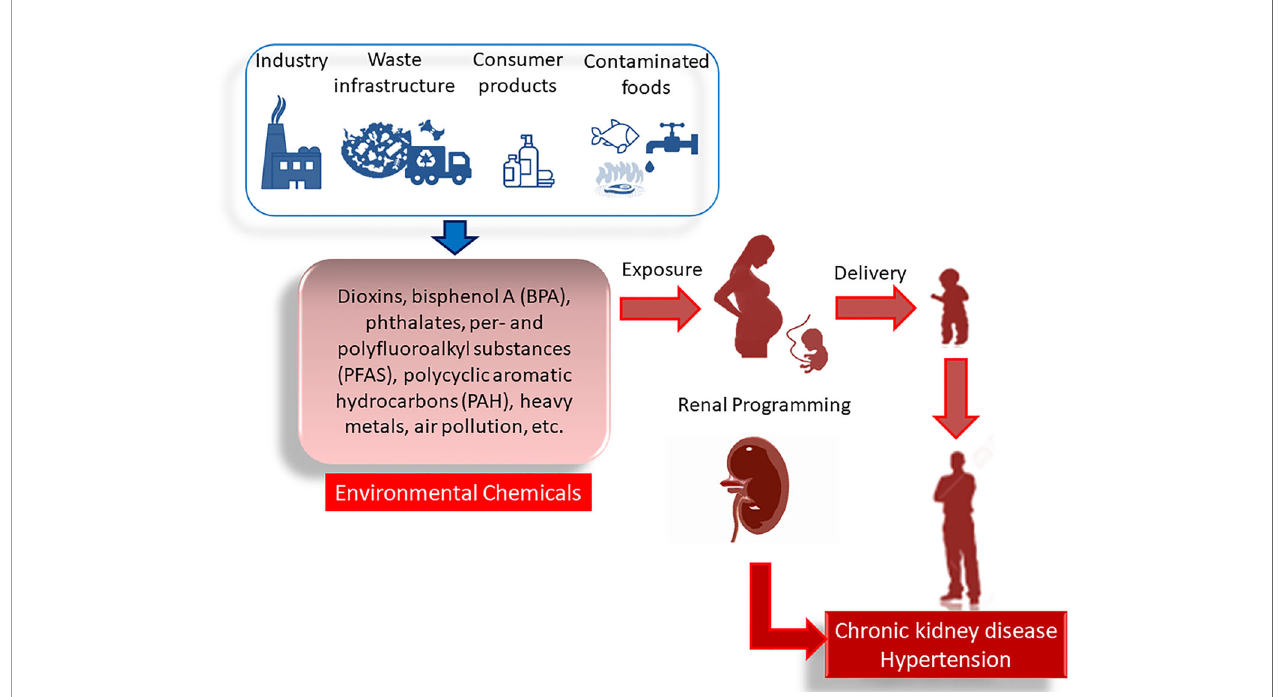
FIGURE 1 | Adverse impact of maternal environmental chemical exposure on developmental origins of kidney disease and hypertension. In pregnancy, exposure to various environmental chemicals occurs through daily consumer activity. There are many sources of contamination like industry, waste infrastructure, consumer products, contaminated foods, etc. These environmental chemicals cause renal programming, resulting in chronic kidney disease and hypertension in